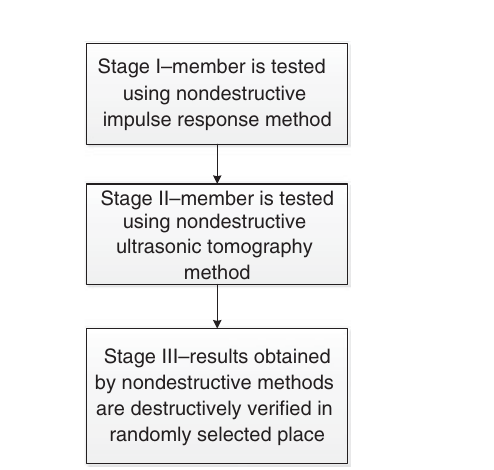
Fig. 2. Hydroelectric power plant access gallery and